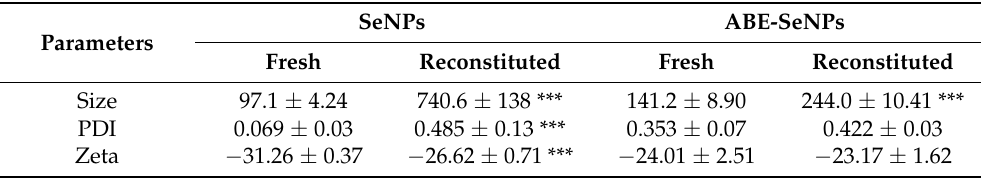
Table 2. Size, PDI, and zeta potential of SeNPs and ABE-SeNPs comparing freshly prepared and reconstituted